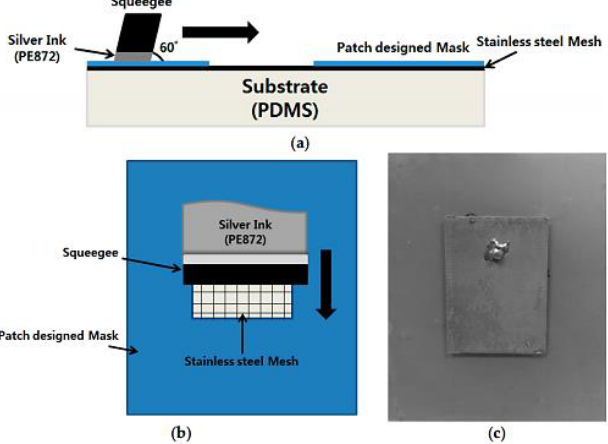
Figure 21. Silver screen printing process: ( a ) side view of screen printing process; ( b ) top view of screen printing process; and ( c ) picture of the fabricated prototype [78].